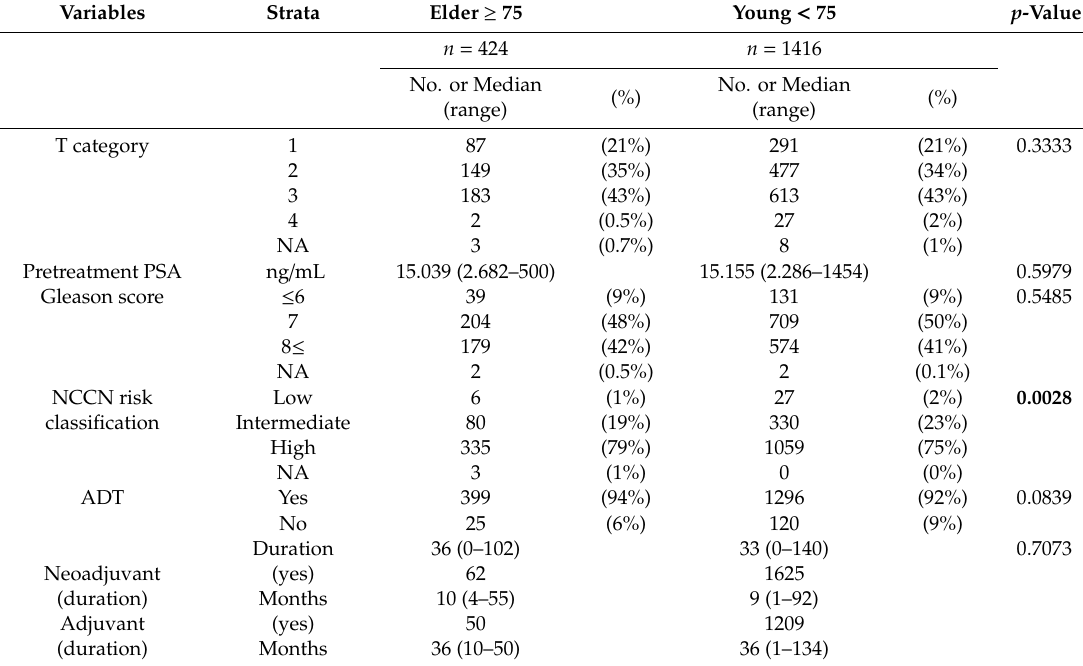
Table 3. Characteristics and treatment factors of elder patients and younger